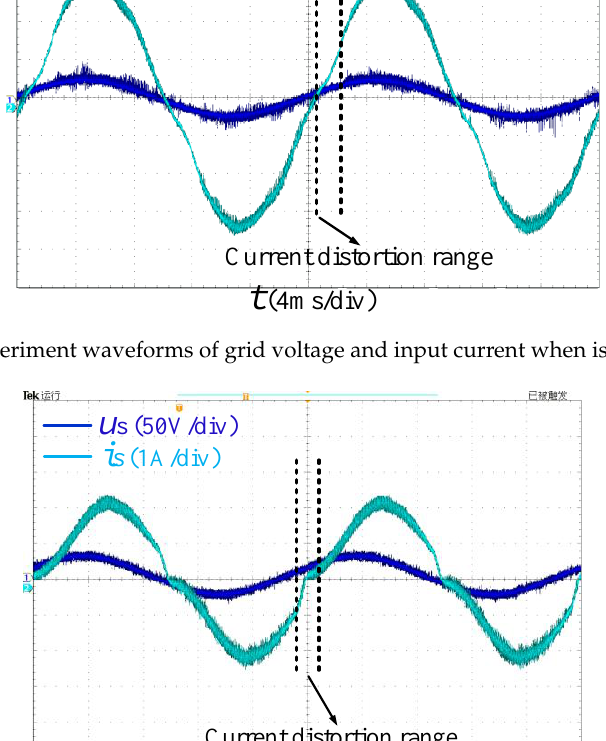
Figure 26. Experiment waveforms of grid voltage and input current when i s lags u s by 40°.